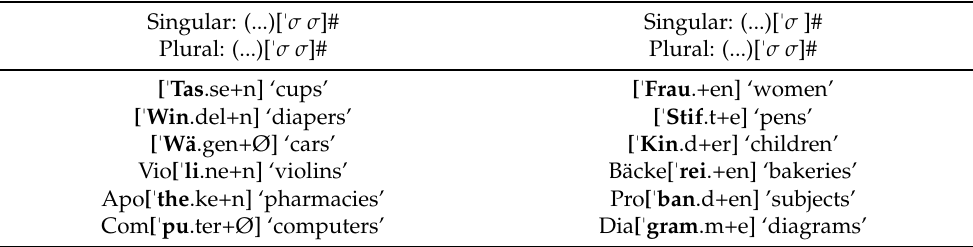
Table 1. Overview of German nominal plural exponency (in orthographic form) for all plural exponents except - s . All examples show nominal plural with a word-final trochee (marked as [ " syllable1. syllable2], indicating the prosodic form: (...)[ " σ σ ]#), independent of the corresponding nominal singular form and the specific plural exponent